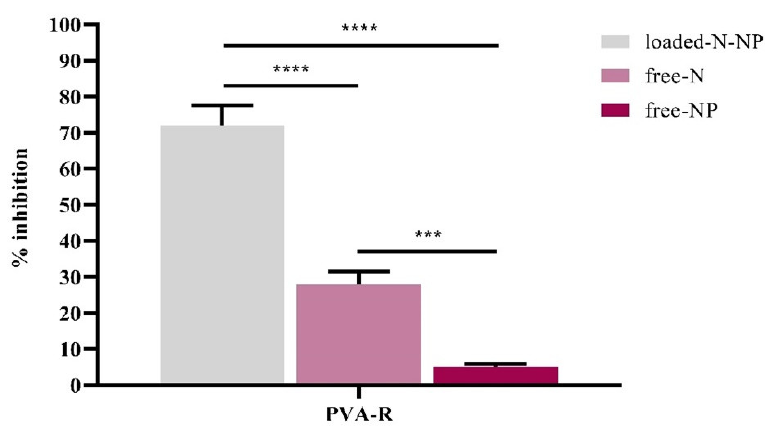
Figure 4. The efficiency of biofilm inhibition of PVA-R NPs. PVA- R NPs, PLGA-NP prepared with PVA-R surfactant. Results were determined as mean ± SD, n = 3. Statistically significant dif- ferences between groups: *** p < 0.0005, **** p < 0.0001 (one-way ANOVA).